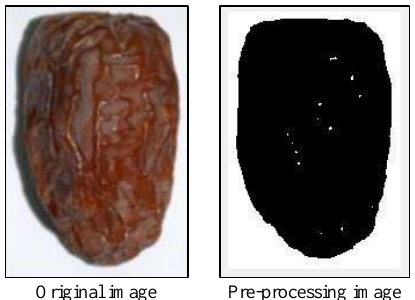
Figure 3. Segmented images using